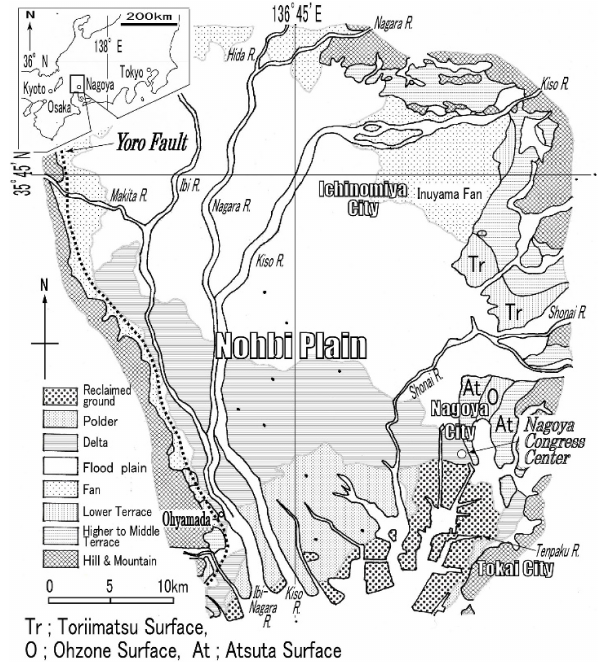
Figure 1. Topography of the Nohbi Plain (Makinouchi et al., 2013).